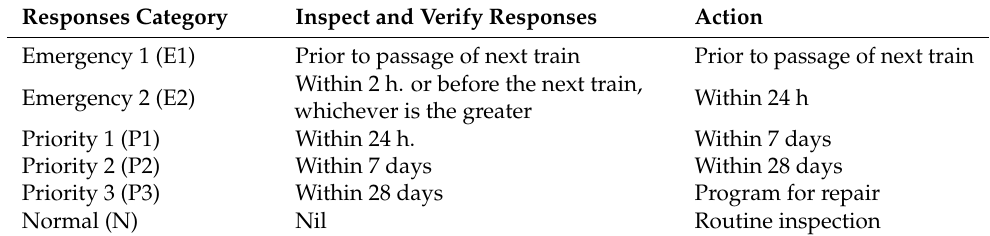
Table 2. Definition of responses